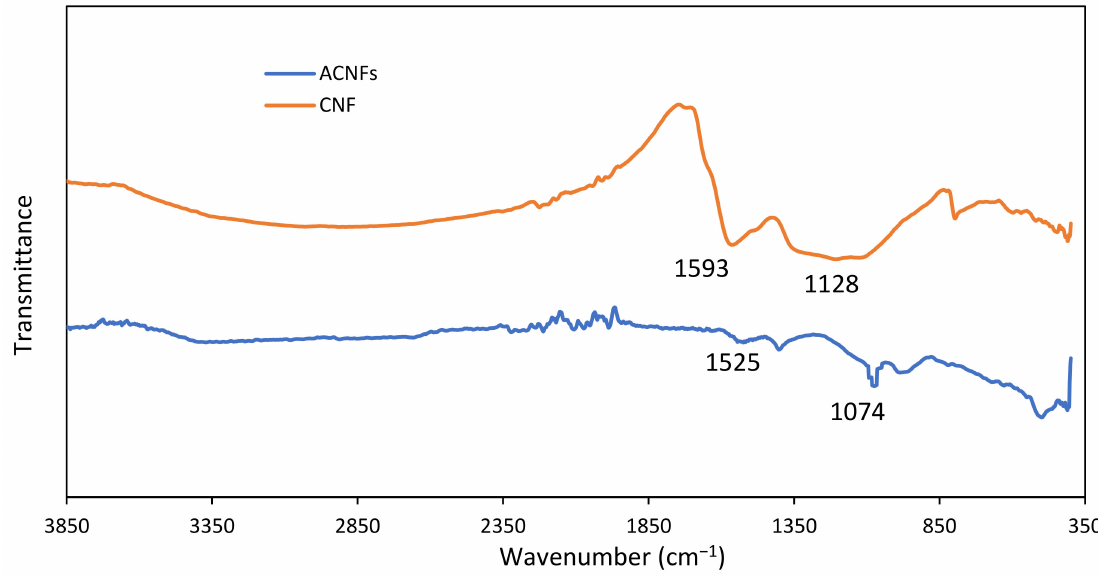
Figure 7. FTIR spectrum of PAN/Lignin/PEG CNF and